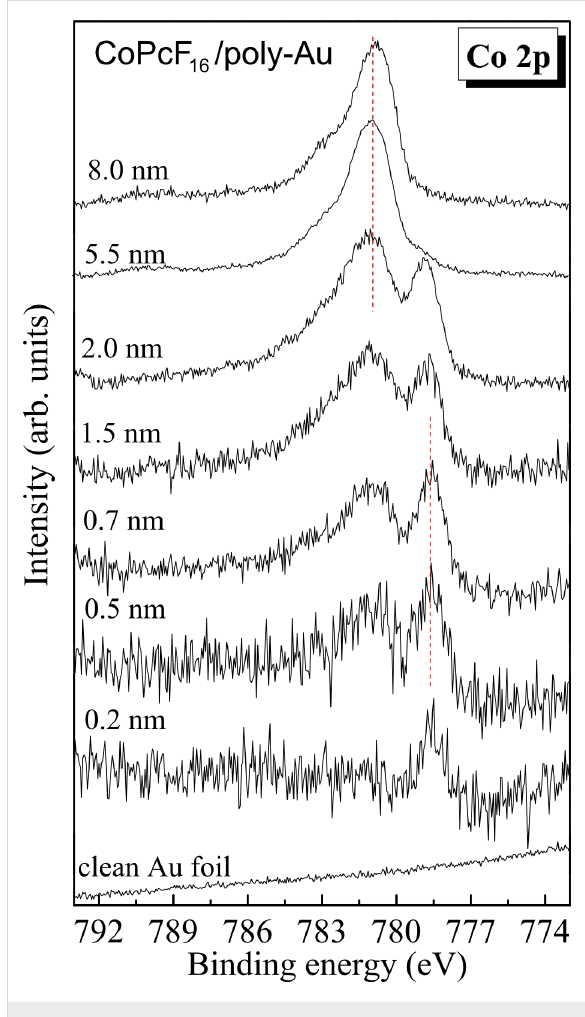
Figure 1: CoPcF 16 on polycrystalline (poly-) Au: Co 2p core-level photoemission spectra (XPS, Al K α ) with increasing CoPcF 16 film thickness on gold